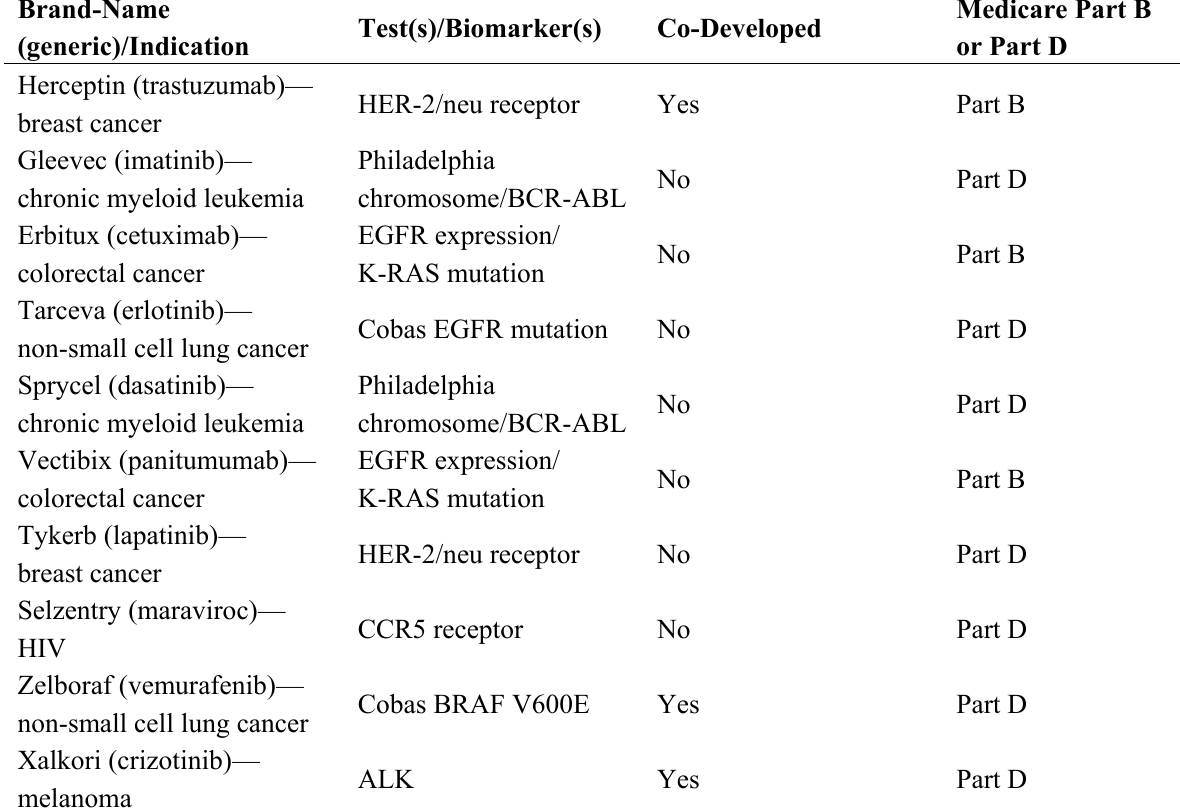
Table 1. 10 Drug-diagnostic combinations.